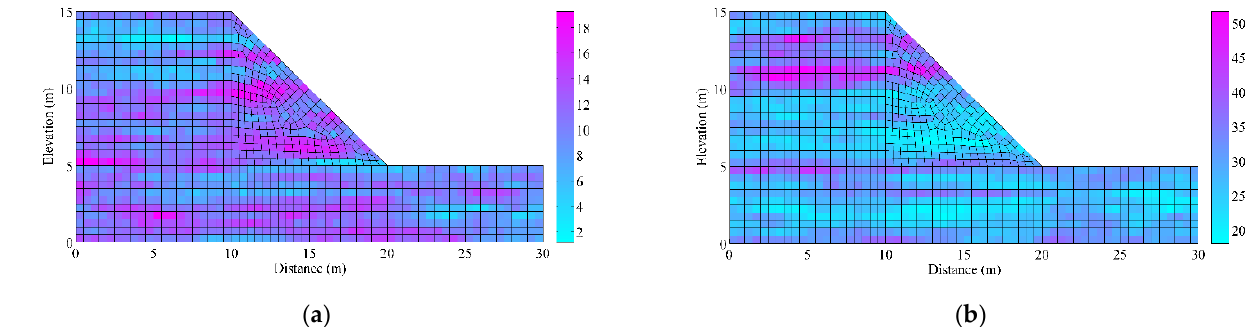
Figure 13. A typical realization of CCRF associated with LN and TN margins. ( a ) Random field of c . ( b ) Random field of ϕ.